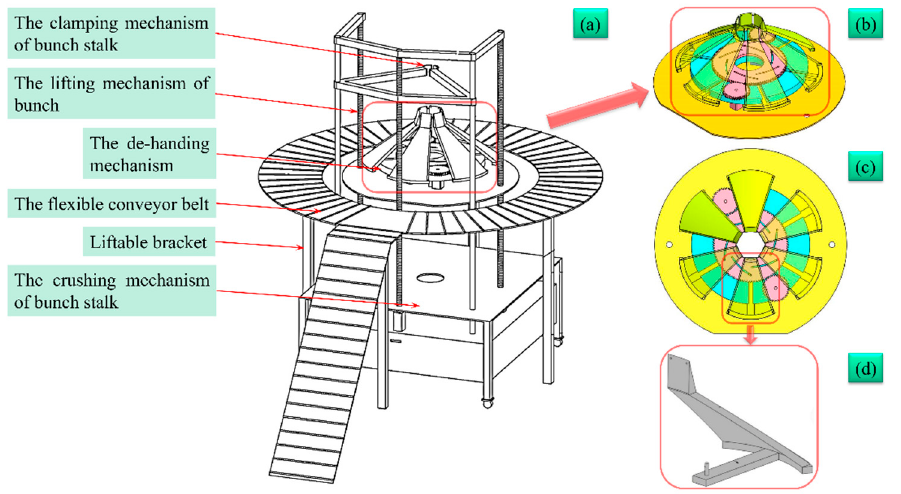
Figure 11. De ‐ handing machine based on iris ‐ gear ‐ like mechanism. ( a ) Schematic diagram of the Figure 11. De-handing machine based on iris-gear-like mechanism. ( a ) Schematic diagram of the structure of de ‐ handing machine, ( b ) Axonometric view of de ‐ handing mechanism, ( c ) Top view of structure of de-handing machine, ( b ) Axonometric view of de-handing mechanism, ( c ) Top view of de ‐ handing mechanism, ( d ) 3D model of arc blade. de-handing mechanism, ( d ) 3D model of arc